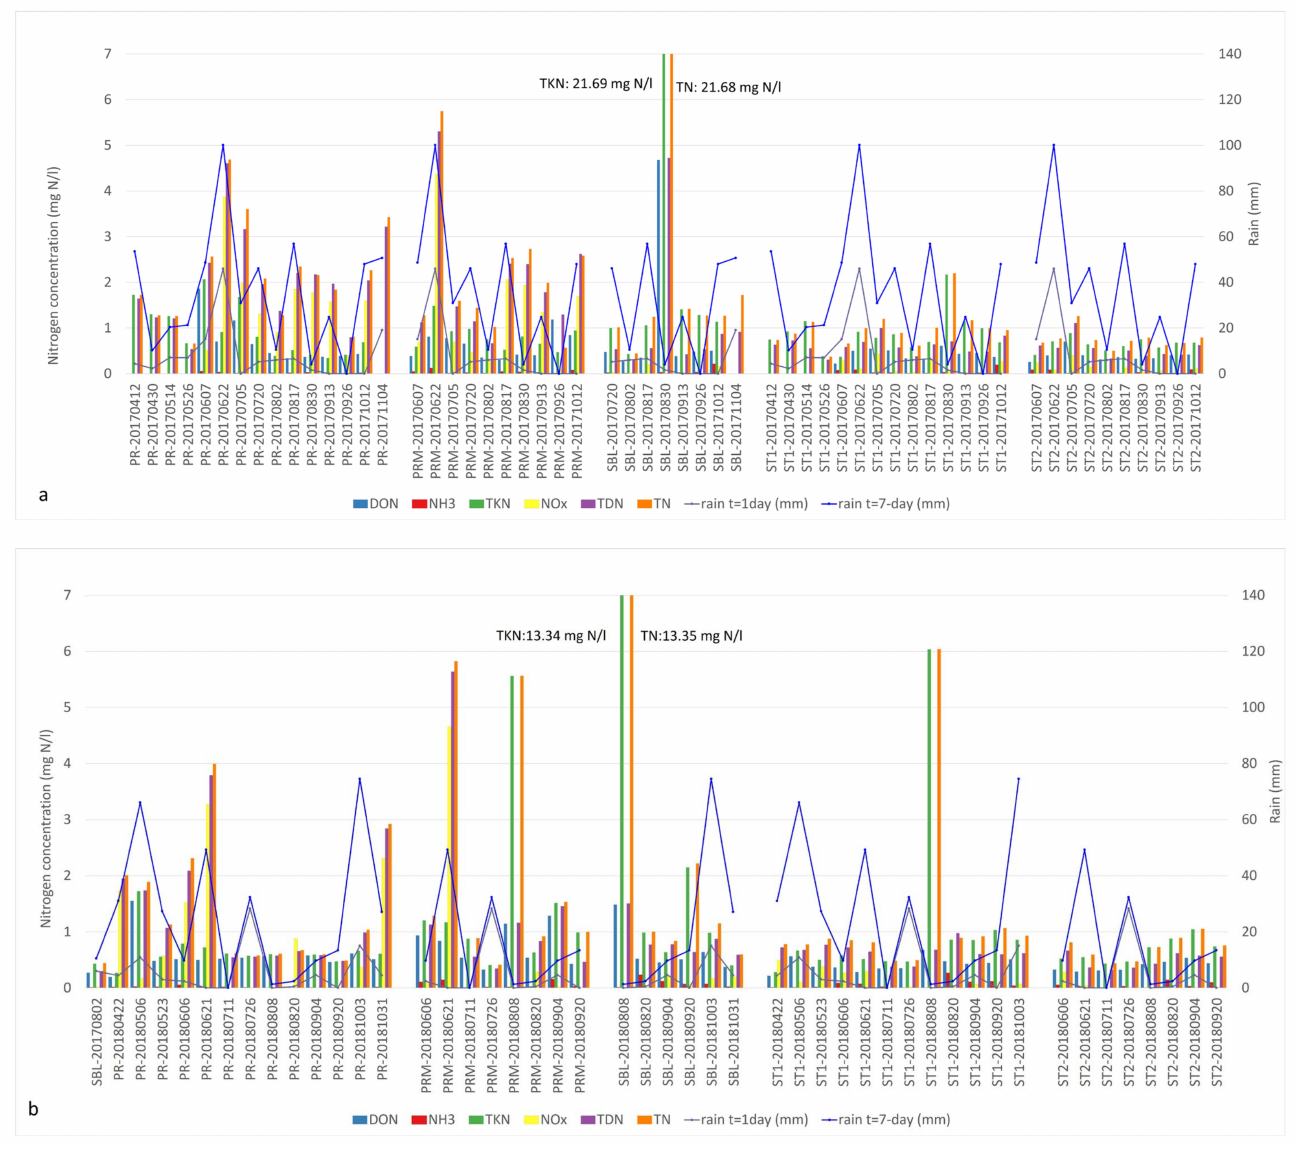
Figure 3. Nitrogen fractions and cumulative precipitation identified in Missisquoi Bay during ( a ) 2017 and ( b ) 2018 sampling campaigns. Occasional spikes of NOx and TDN concentrations in PR and PRM sites in June and October in both years corresponded to high cumulative rain. Extreme TKN values corresponded to intense bloom episodes. Concentrations exceeding the value axis are indicated in the text